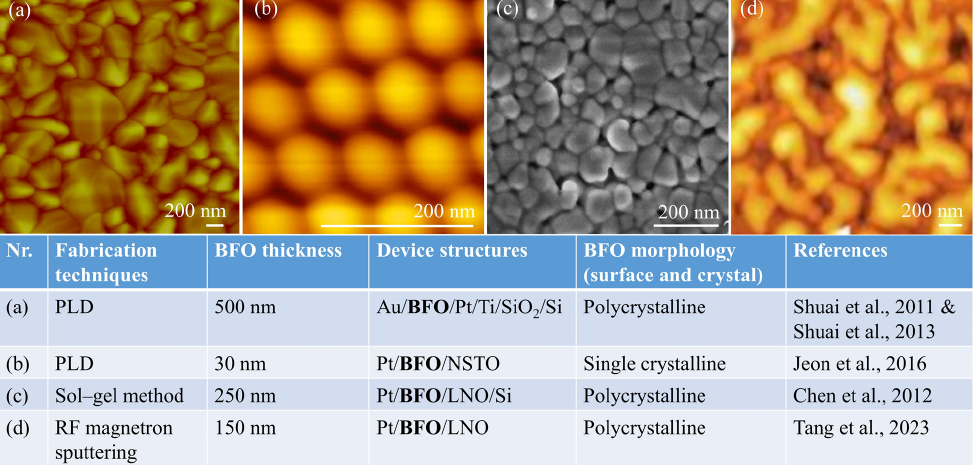
Figure 2. Crystal structures of BFO memristive devices summarized in the table along with atomic force microscope topography images demonstrating various fabrication techniques, ( a ) Thin film, ( b ) Nanoislands, ( c ) Thin film, and ( d ) Thin film. All images are reproduced with permission from the corresponding references in Refs.